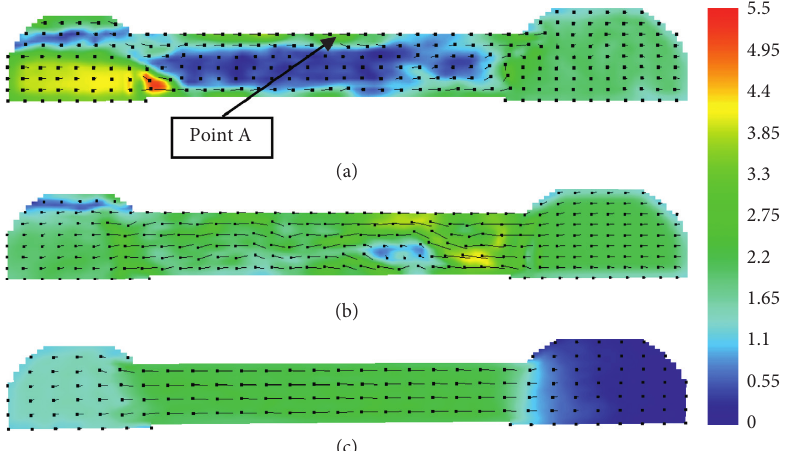
Figure 5: (a) Vector-graph of flow velocity (ms − 1 ) in the cross channel of Scheme 2. (b) Vector-graph of flow velocity (ms − 1 ) in the cross channel of Scheme 3. (c) Vector-graph of flow velocity (ms − 1 ) in the cross channel of Scheme 5. –7–6–5–4–3–2–10